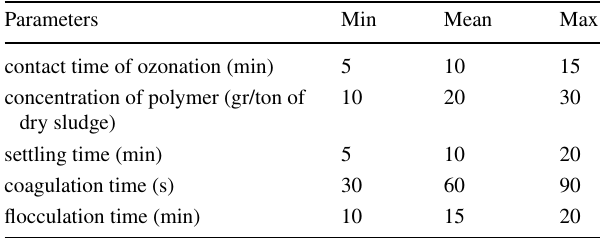
Table 1 Evaluated independent parameters in this study Parameters